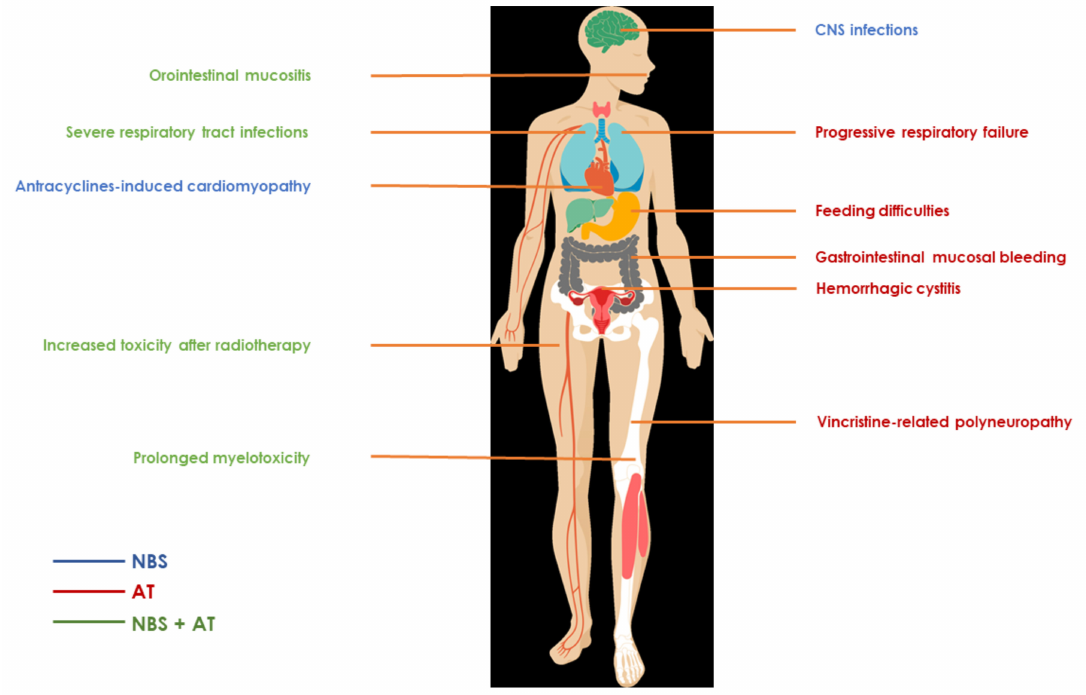
Figure 2. Common treatment-induced toxicities in patients with DNA repair disorders. The color of the font represents specific syndrome: blue—NBS; red—AT; green—both NBS and